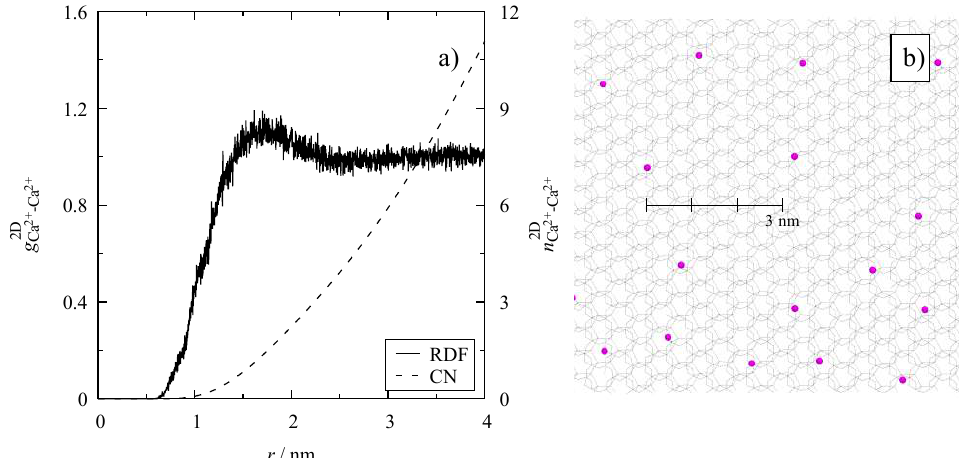
Figure 8. Lateral radial distribution function (RDF; g ij ) and integrated coordination number (CN) of Ca 2+ cations on the siloxane side at distance r confined in 0 < z < 0.6 nm space ( a ). Top view ( xy –plane) of Ca 2+ cations (magenta balls) adsorbed on the siloxane surface of kaolinite (gray lines) ( b ).